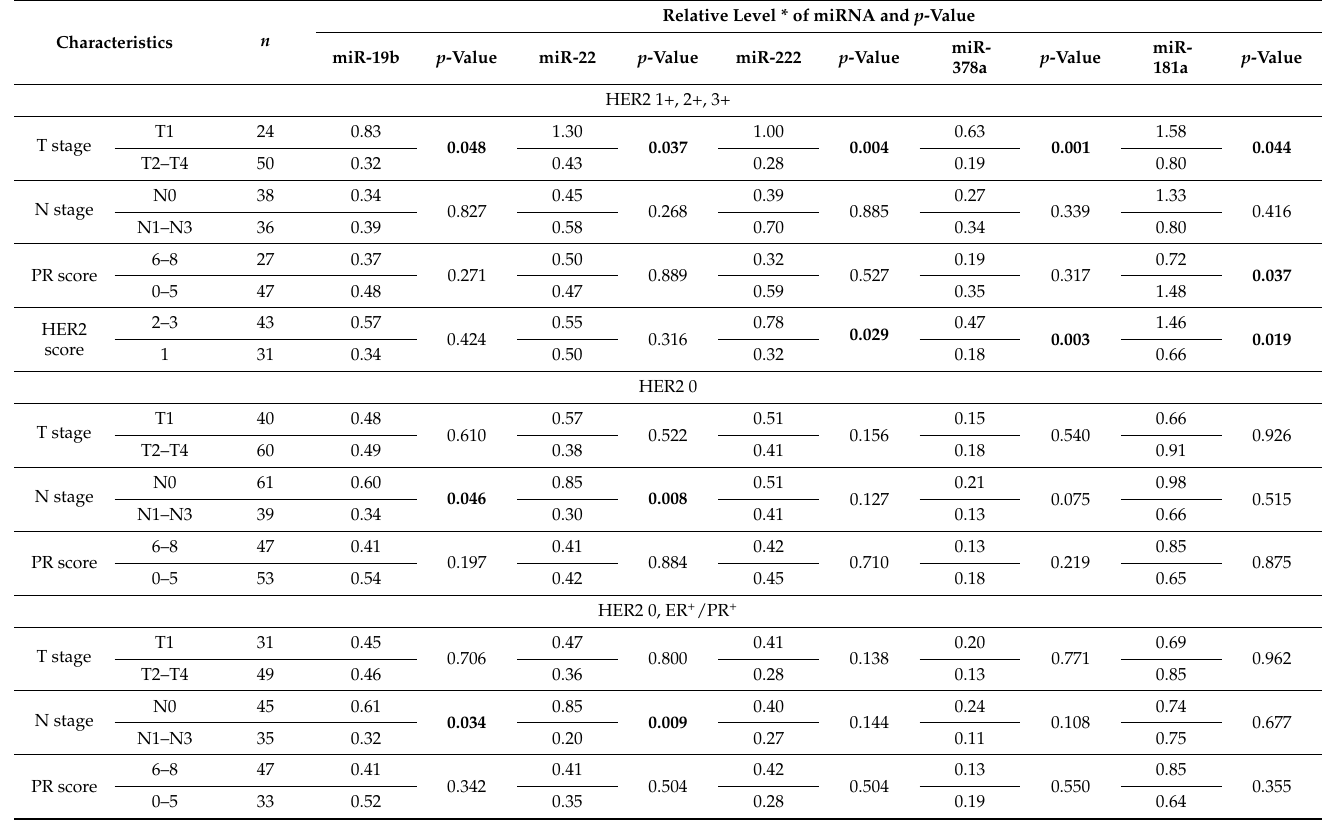
Table 5. Association of miR-19b, miR-22, miR-222, miR-378a and miR-181a expression with clinicopathologic characteristics of HER2 1+, 2+, and 3+ tumors and HER2 0